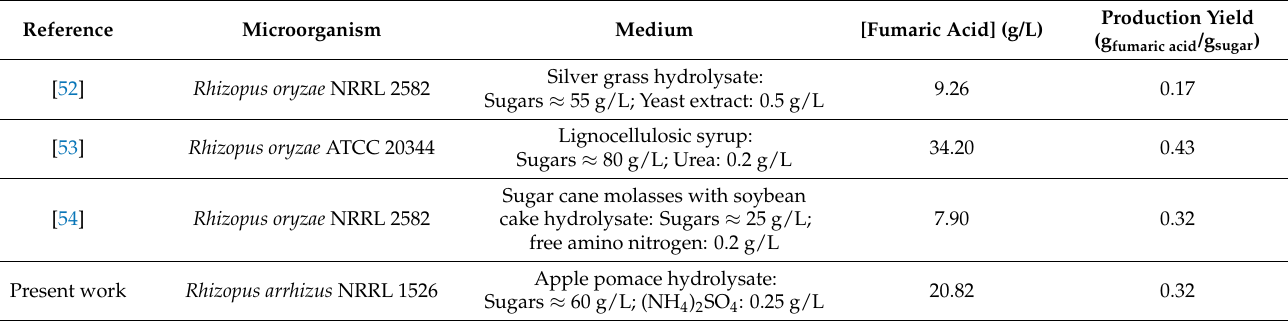
Figure 6. Experimental results (points) and simulation (lines) by means of the kinetic modelling applied on Experiment 4 (APH, [NH 3 ] 0 = 0.25 g/L, 200 rpm, 34 °C). Table 3. Comparative of fumaric acid production using different wastes